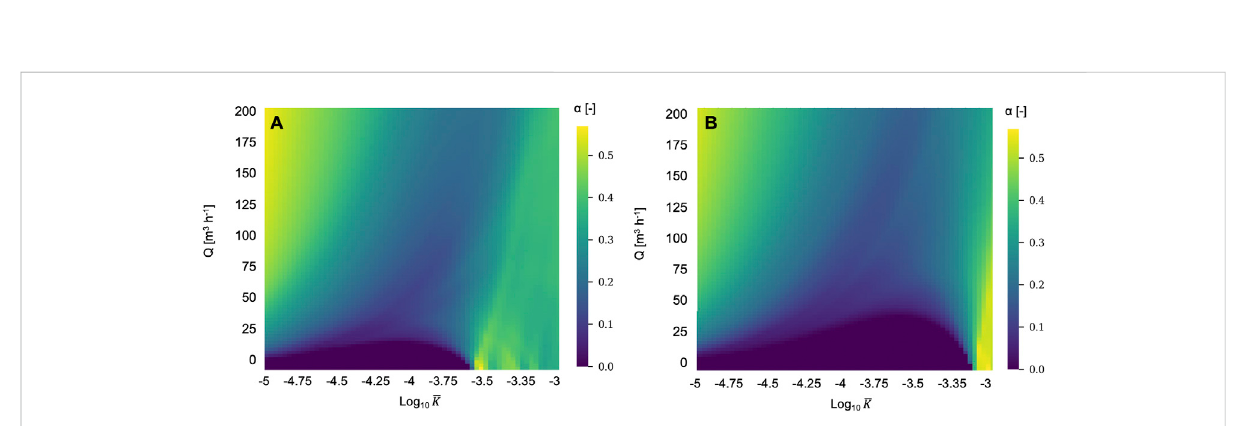
FIGURE 4 Distribution of the mixing ratio α depending on the average hydraulic conductivity (cid:1) K and pumping discharge Q for the hydraulic conductivity patterns presented in (A) Figures 1B and (B) Figure